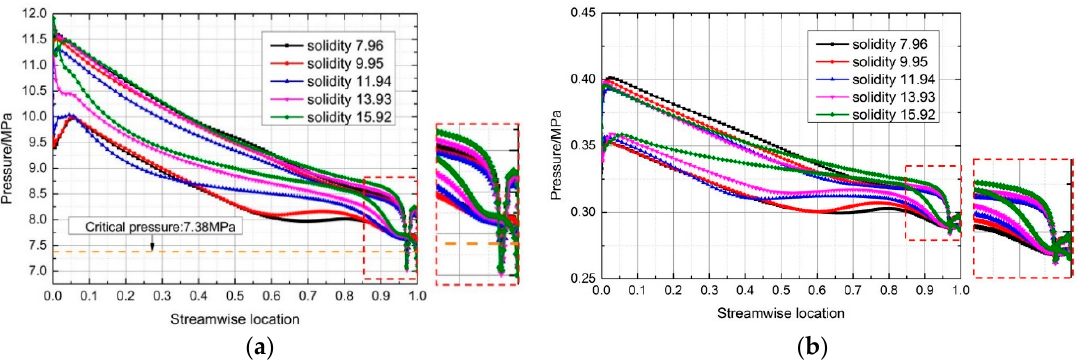
Figure 15. Rotor blade load along streamwise location of different solidity: ( a ) SCO 2 ; ( b ) air.